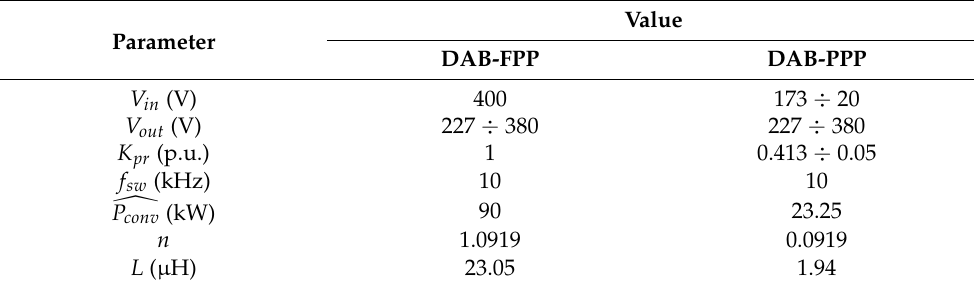
Table 1. Main electrical parameters of the DAB-FPP and